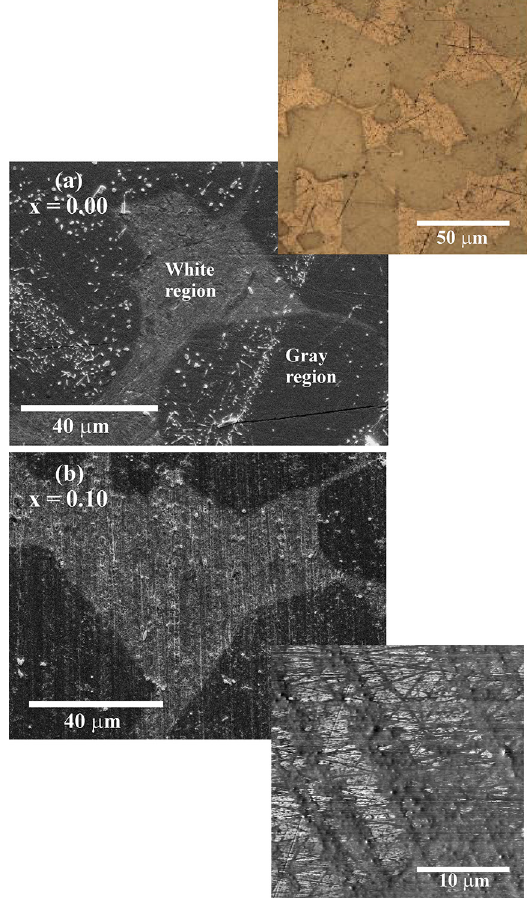
Figure 3. Backscattered electrons SEM micrographs for a polycrystalline sample of Bi Ni Fe with (a) x = 0.00 and (b) x = 0.10. We can 3 1-x x clearly observe two regions, labeled white and gray. Upper inset: optical image of the polycrystalline of Bi atomic force micrograph of a polycrystalline Bi in phase mode using a Si